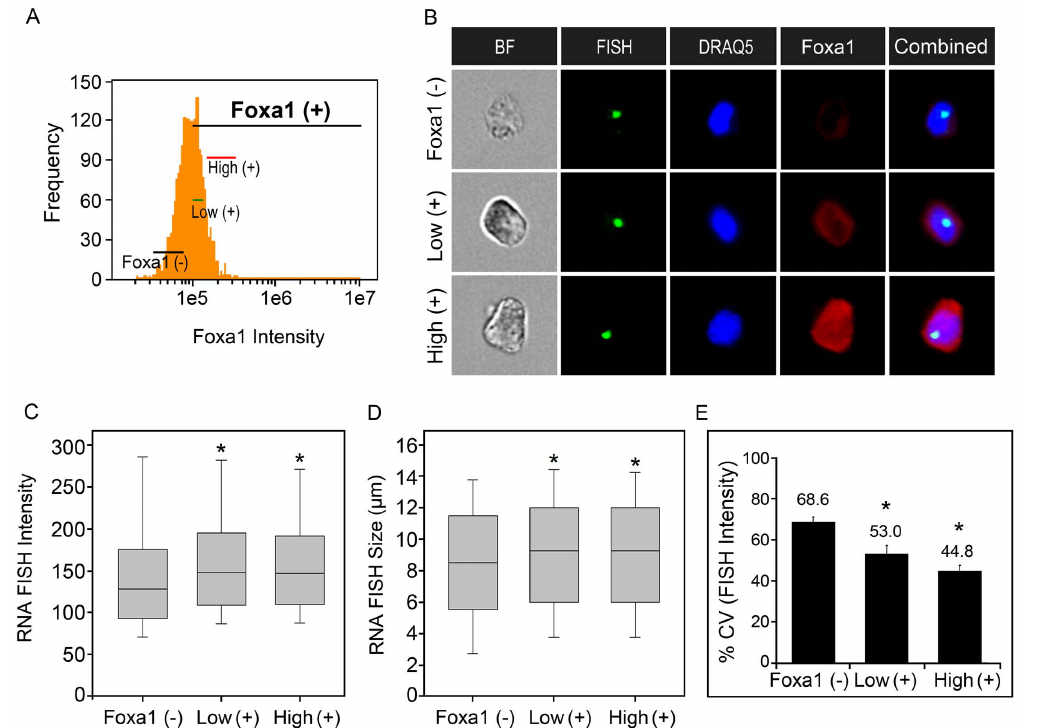
Figure 5. Foxa1 increases the median MMTV-Ras transcriptional response and decreases cell-to-cell variability in the FISH signal intensity. (A) Gating of sub-groups of cells representing no Foxa1 expression, low and high Foxa1 expression used for in-depth analyses of MMTV transcriptional variability. (B) A gallery of representative images of cells within the three sub-groups showing different degrees of Foxa1 immunofluorescence. (C, D) Box-and-whisker plots of the RNA FISH signal intensity (mean pixel intensity units) and size ( m m) distributions within each sub-group. (E) Computation of the individual cell-to-cell variability in the FISH signal intensity using the % CV. Each % CV is calculated from greater than 100 cells. The % CV shown represents the mean + SEM from 4 independent experiments. *, indicates a significant difference from the Foxa1 negative (-) sub-group as determined by the Mann-Whitney U Test (p , 0.05).